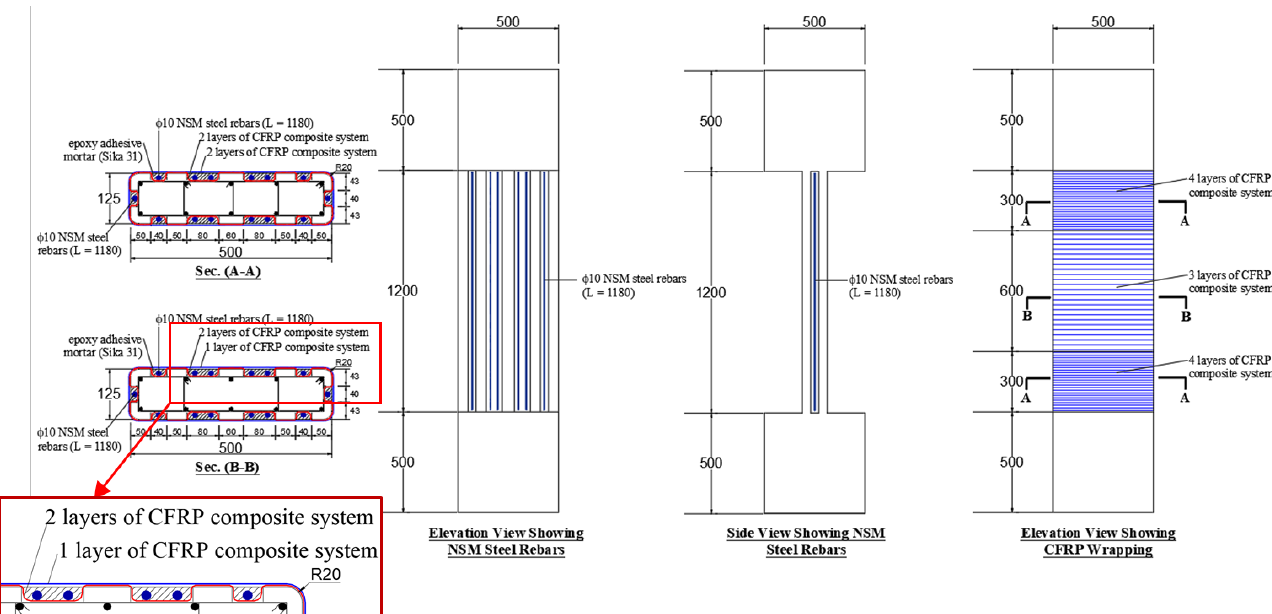
Figure 4. Dimensions and reinforcement detailing of strengthened specimen SW3 (note: all dimen- sions are in mm).